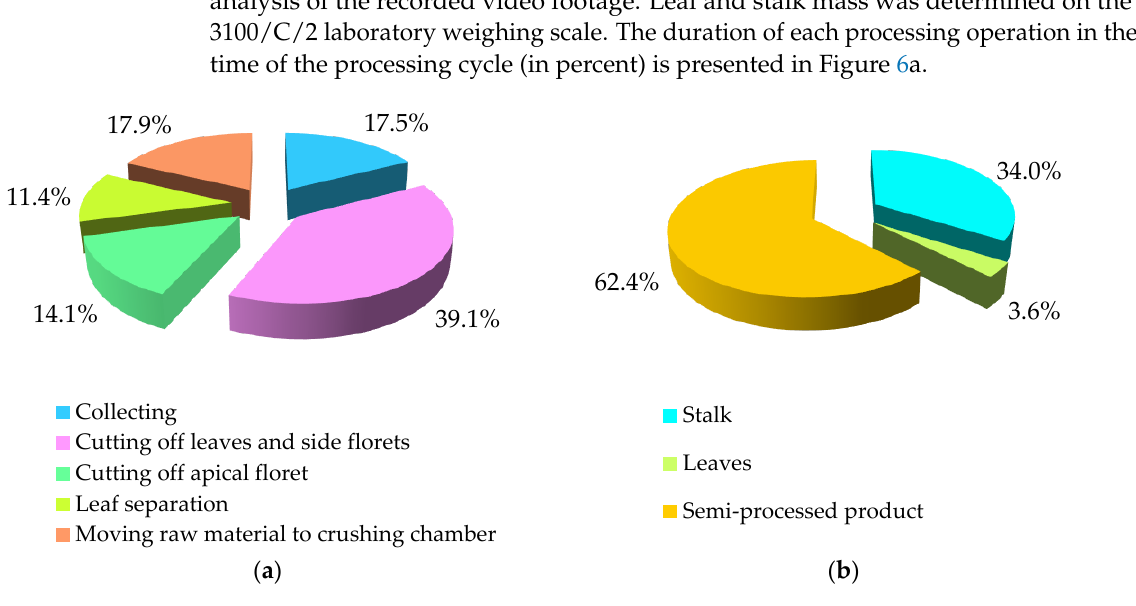
Figure 6. Duration of each processing operation in the process of broccoli floretting (in %) ( a ); and the proportion of different fractions in the mass of a broccoli head ( b ).